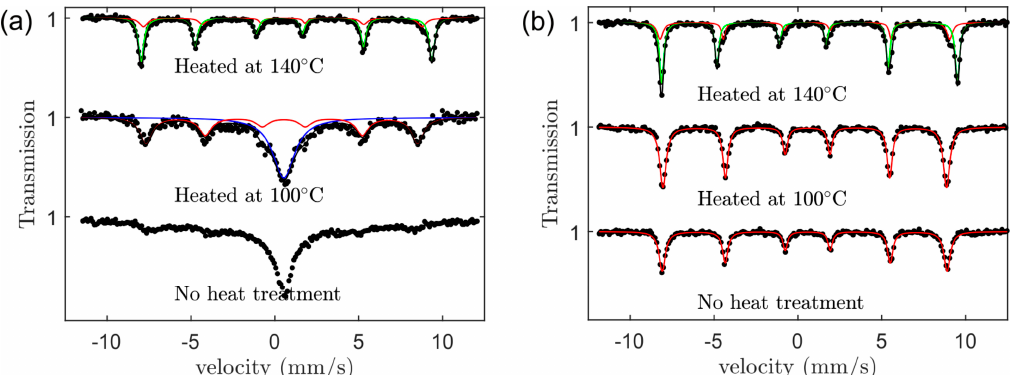
Figure 12. Mössbauer spectra of the hematite sample with 2.5 mM NaCl heated at the indicated temperatures. ( a ) Measurement at 80 K; ( b ) Measurement at 20 K. Fit to the superparamagnetic doublet is plotted in blue, and sextets for hematite with and without Morin transition are plotted in green and red, respectively.